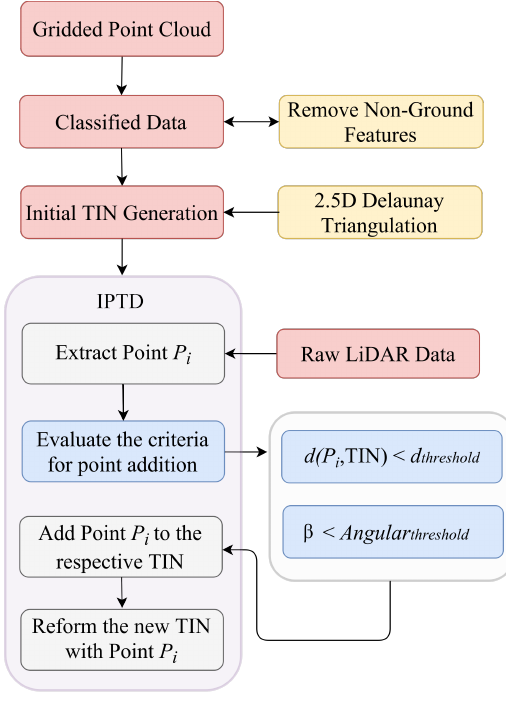
Figure 5. Flowchart for DEM generation